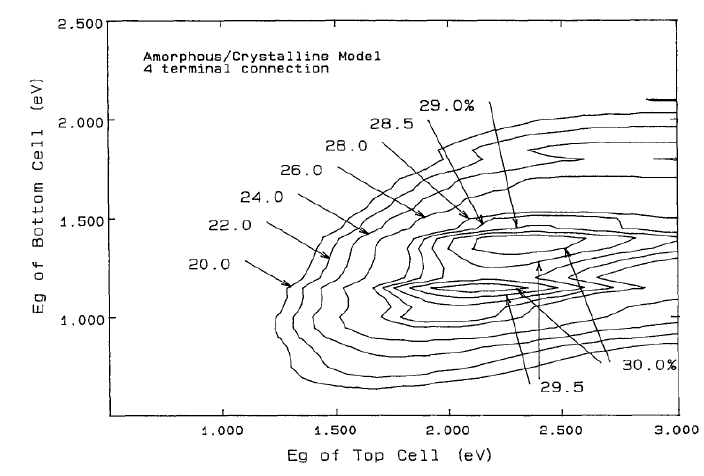
Figure 4. Calculated isoefficiency map for dual-junction four-terminal solar cells under AM1.5G spectrum at one-sun illumination according to the top and bottom cell bandgaps (reprinted from [12]; © 1992, with permission from The Japan Society of Applied Physics).